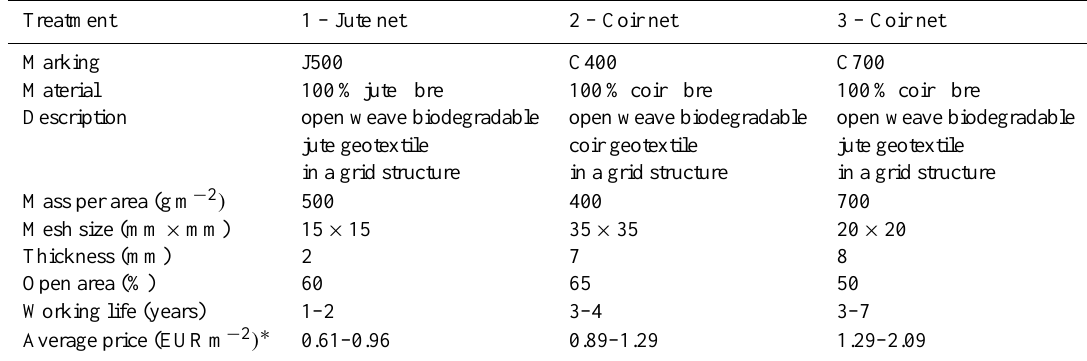
Table 2. Main characteristics of three tested biological